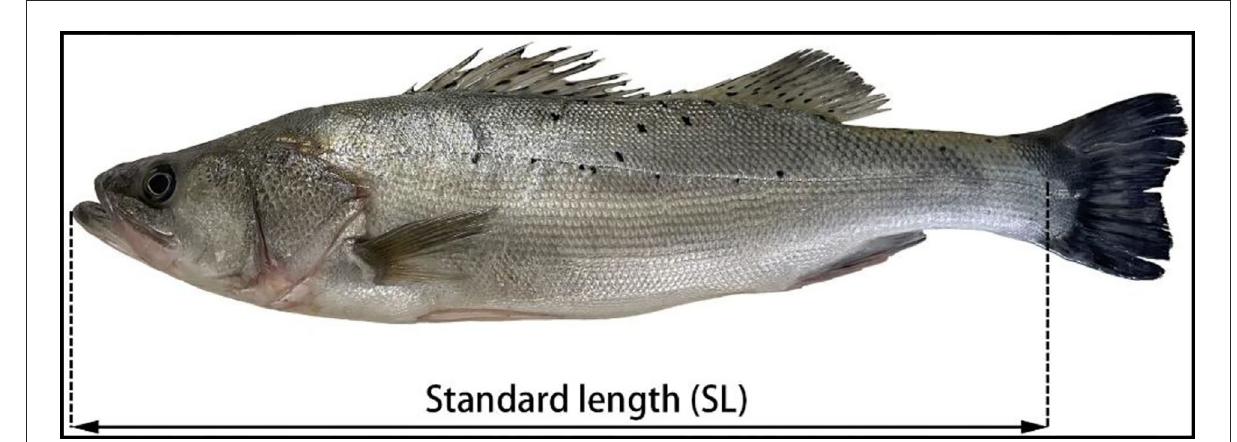
FIGURE1 Chinese sea bass and measurement illustration of standard length